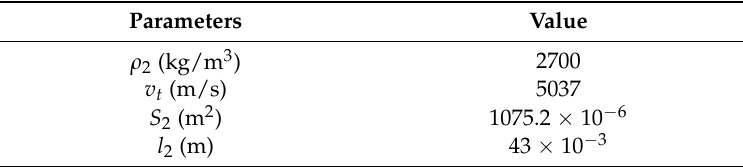
Table 2. The material parameters of the aluminum used in the front mass.